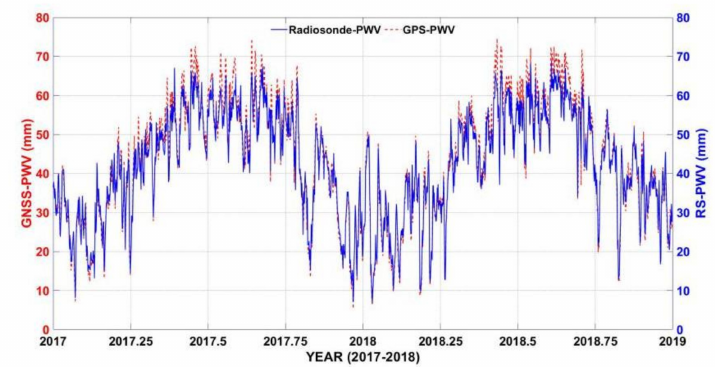
Figure 2. Comparison of the time series of GNSS-PWV at the HKSC station against RS-PWV (the reference) during the period